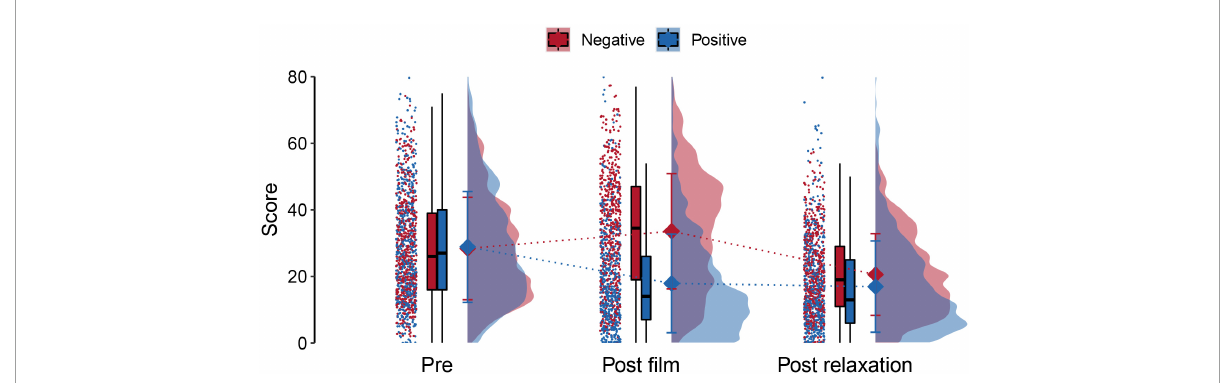
FIGURE2 Total scores of the emotional state scale before the experiment (pre), after watching the animated short films (post-films), and after the relaxation (post-relaxation) in the positive (blue) and negative (red) short animated film groups. Dots to the left of each phase of the experiment represent scores of each participant at each experimental phase. Boxplots contain the median and first and third quantiles for each group at each experimental phase. Diamonds represent the mean scores of each group at each experimental phase, and error bars represent the standard deviation of the mean, and these are accompanied by kernel density estimates of the data distribution. The ANOVA revealed a significant main effect of the film group ( p < 0.001), a main effect of time ( p < 0.001), and a significant film group by time interaction ( p <